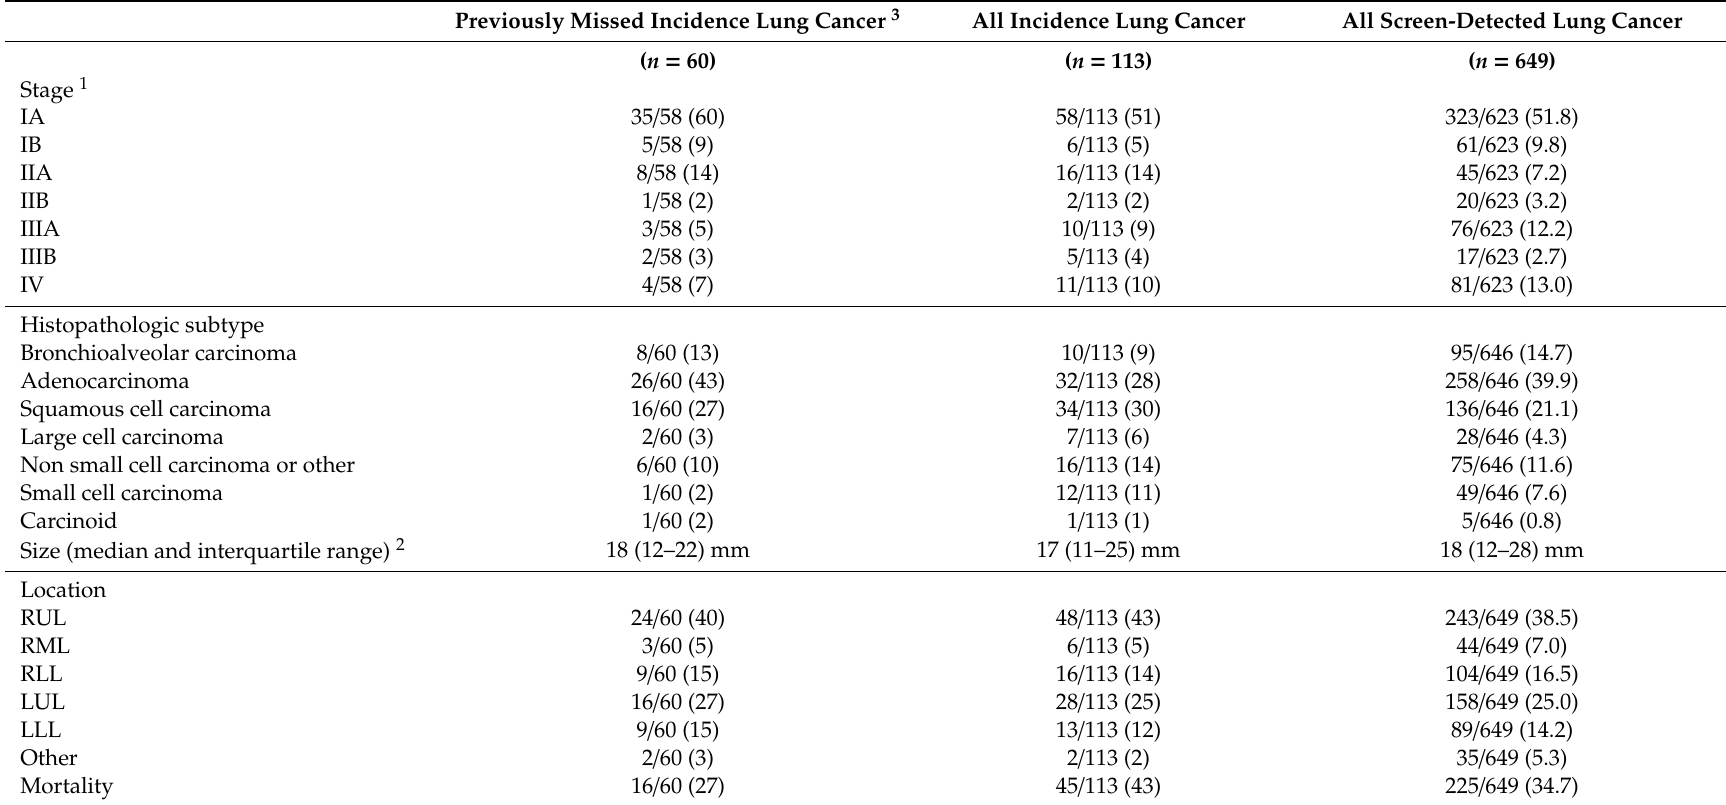
Table 1. Clinical and histopathologic characteristics of lung